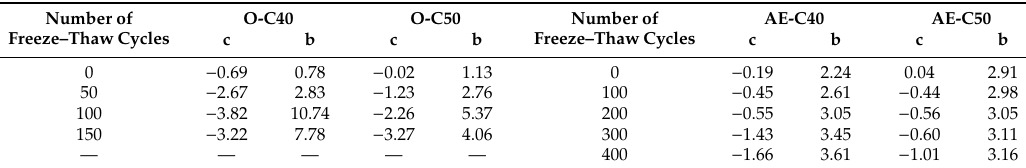
Table 2. The parameter fitting results of the new